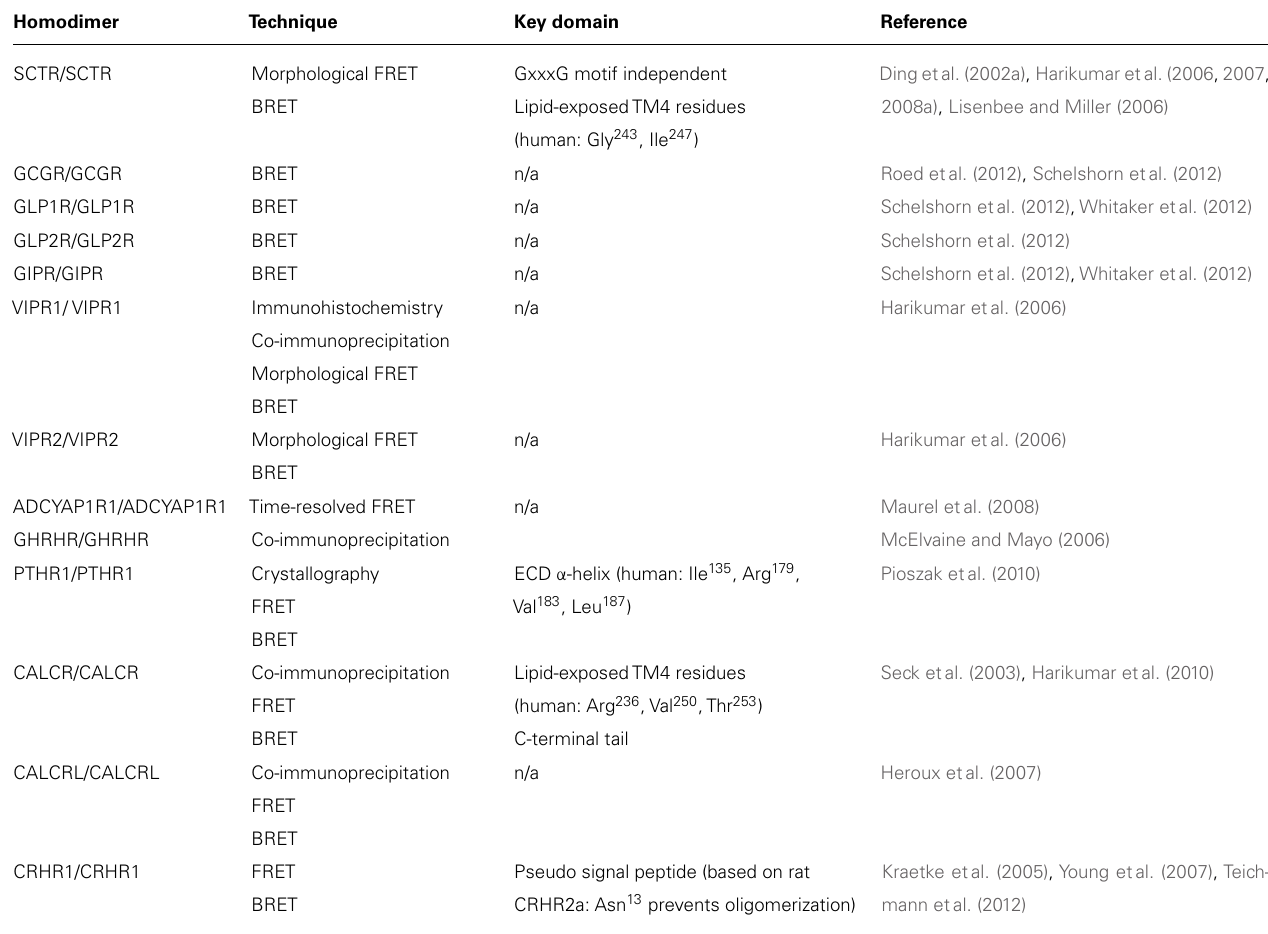
Table 1 | Homodimerization of class B